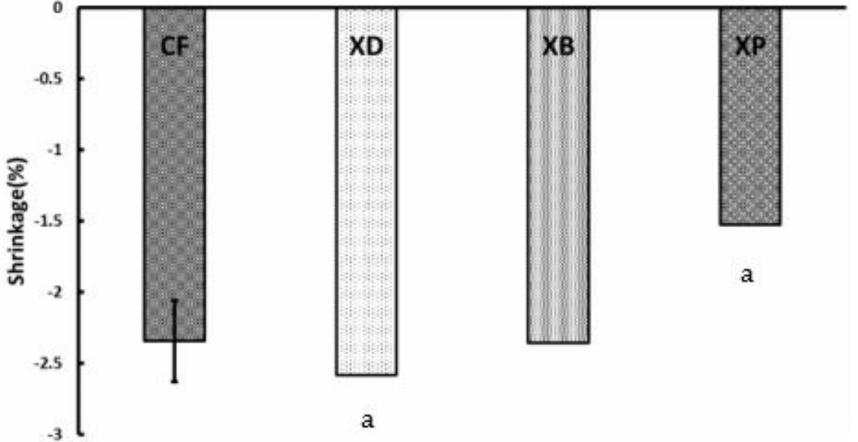
Figure 2. Final polymerization shrinkage rate of short fiber reinforced composites. (Significant difference between the same letters: p < 0.05, I: 95% confidence interval).